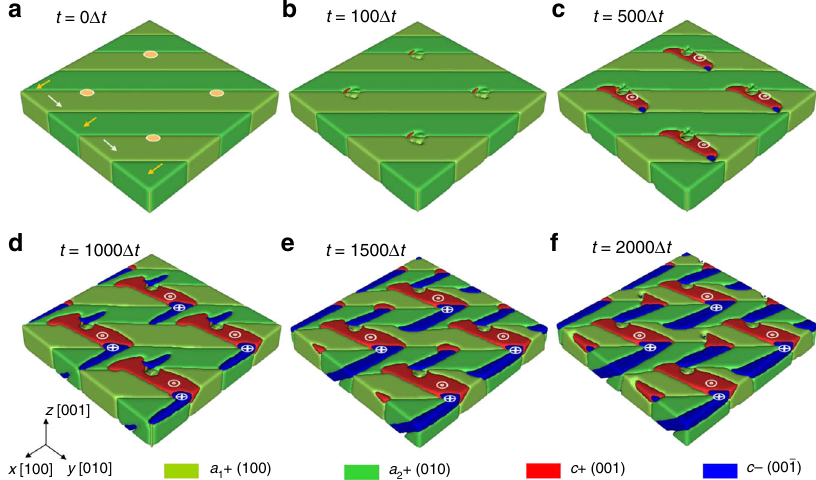
Fig. 4 Phase- fi eld simulations of mechanical force-induced domain evolution. The fi lms with a 1 / a 2 domains are subjected to 0.5% tensile strain. a As- grown a 1 / a 2 state at t = 0 Δ t with illustration of probe tip force locations as noted by four circles, and arrows indicate the polarization directions of a 1 / a 2 domains, b t = 100 Δ t where c domains emerge around the tip-sample contact area, c t = 500 Δ t where more c + domains (red area, polarization up, noted with ⊙ ) are formed and c domains (blue area, polarization down, noted with ⊕ ) adjacent c + domains begin to emerge, d , t = 1000 Δ t where c domains penetrate all the way down to the bottom, e , t = 1500 Δ t and f , t = 2000 Δ t where more c domains begin to form, resulting c/a domains